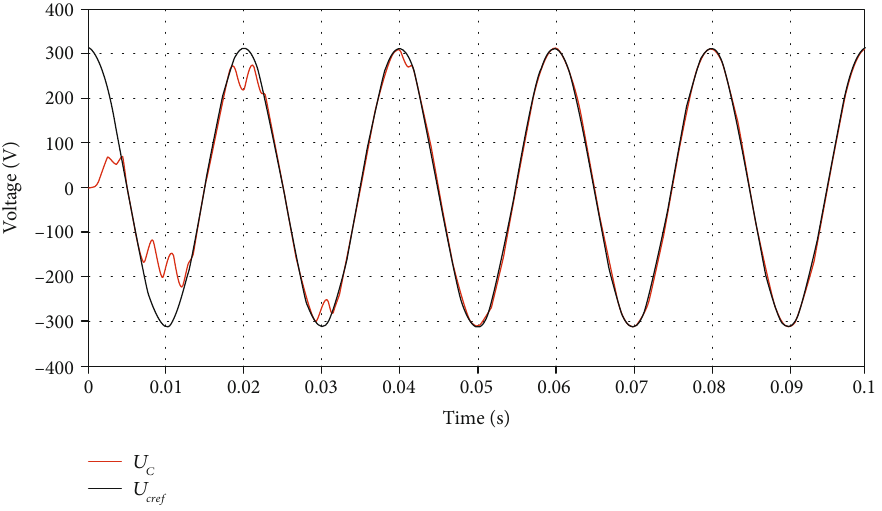
Figure 19: Output voltage inverter after fi ltering with its reference (zoom area).